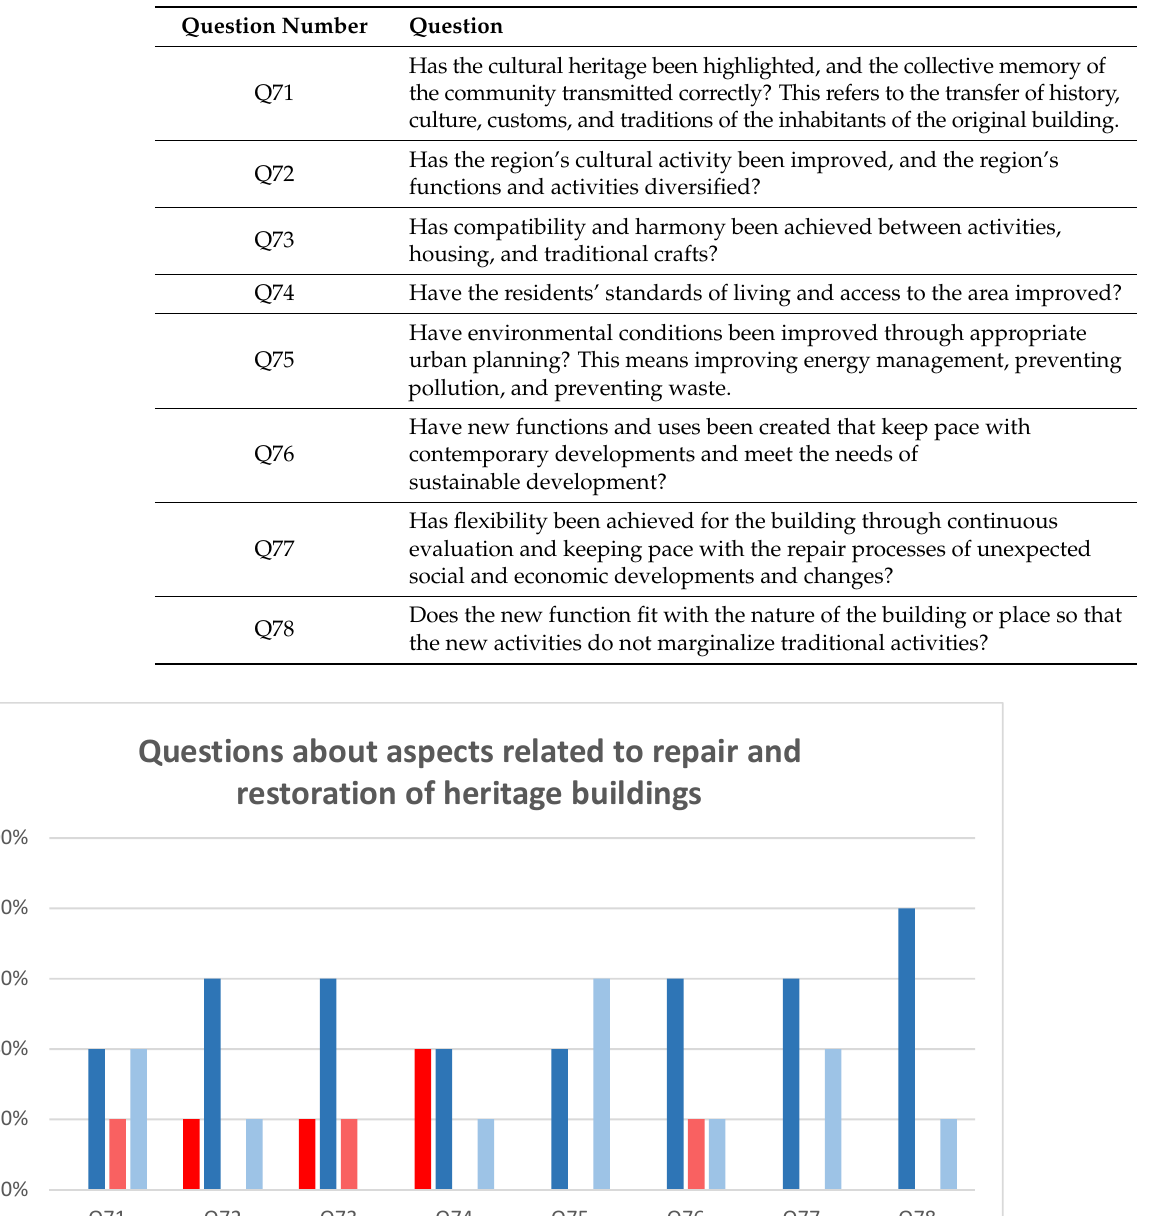
Table 15. Questions about aspects related to repair and restoration of heritage buildings.